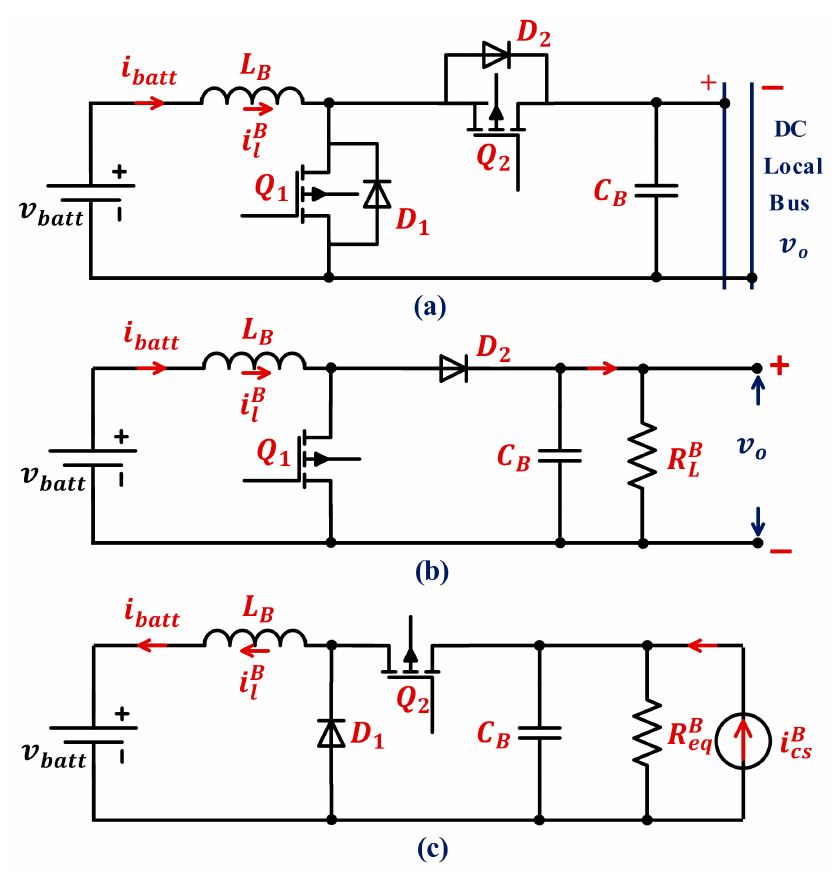
Figure 11. ( a ) Bi-directional converter configuration, ( b ) configuration during discharging mode, ( c ) configuration during charging